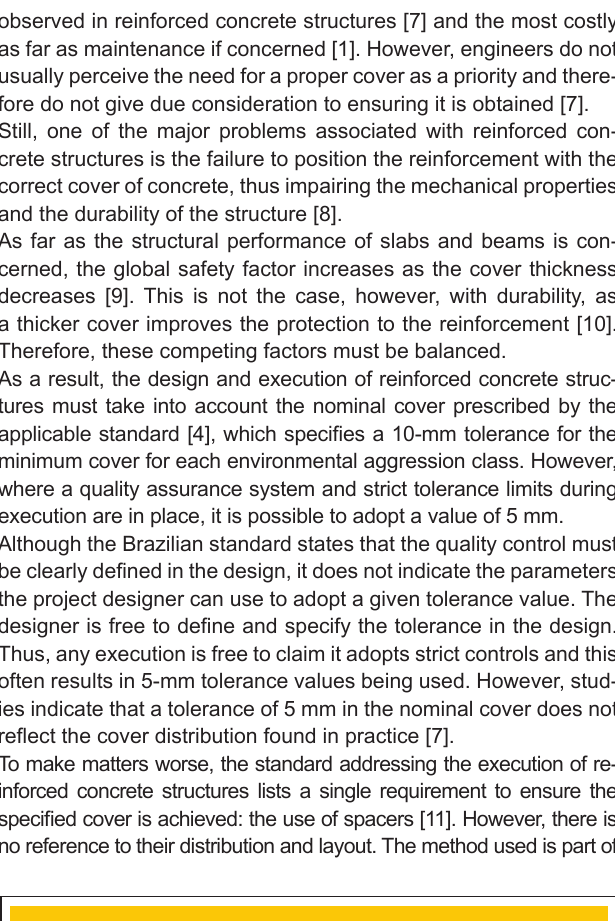
Figure 1 – Tying points 15 cm apart with spacers 60 cm apart